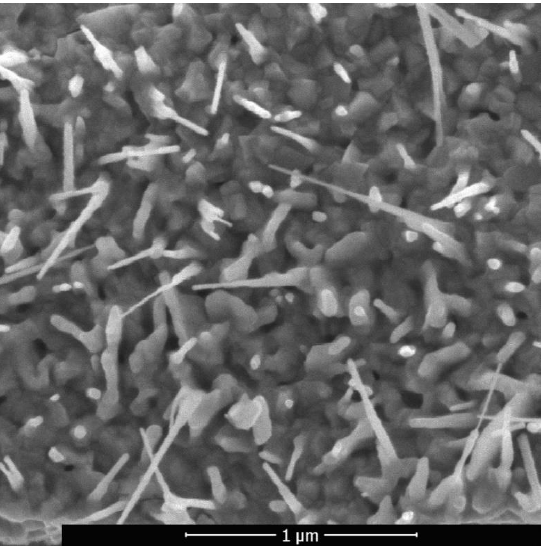
Figure 7. Scanning electron microscopy (SEM) image of ZnO nanowires.